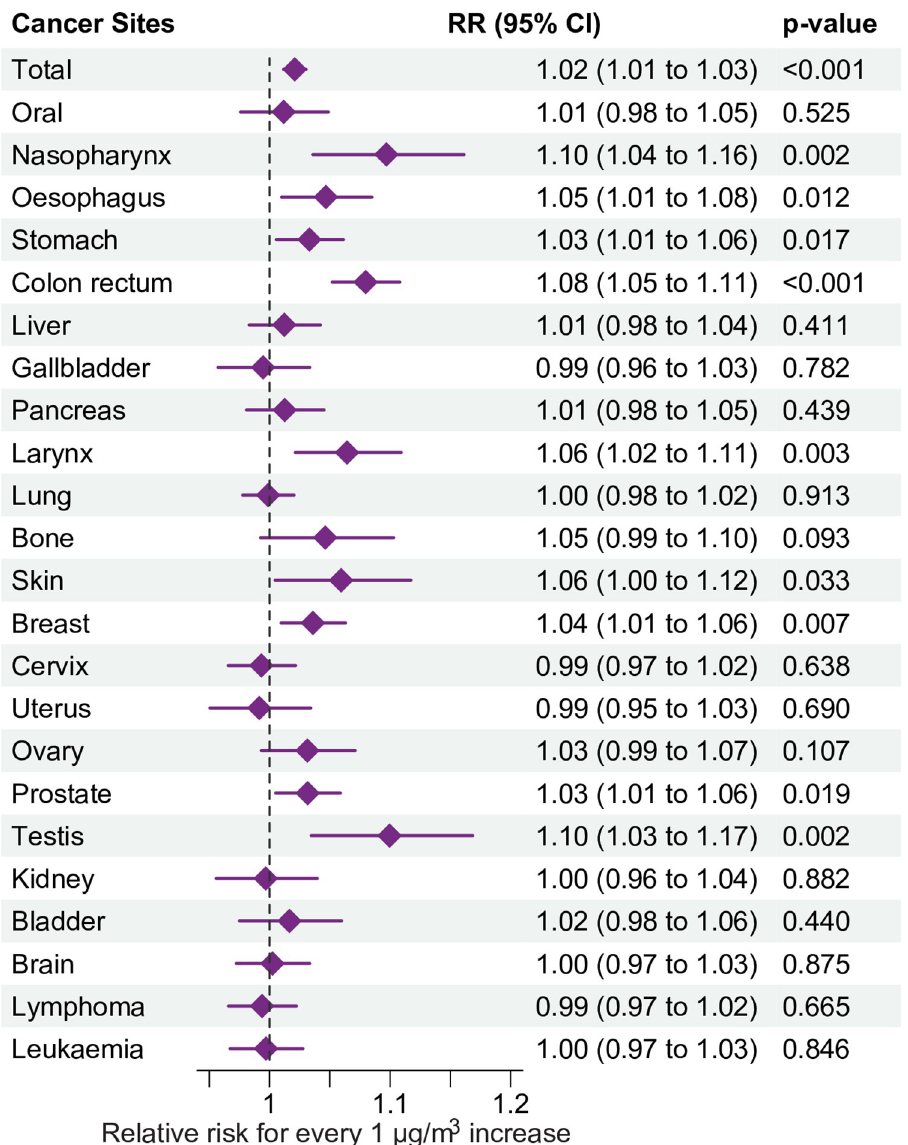
observed between cervical cancer and wildfire-related PM , adverse effects (1.03 [95% CI 2.5 1.01–1.04], p = 0.001) were found for non-wildfire PM (S5 Fig). 2.5 To further examine vulnerable cancer sites and population subgroups, stratified analyses for mortality from potentially affected cancers by age and sex are shown in Fig 4. There was no significant difference for all cancers combined between males (1.02 [95% CI 1.01–1.04], p < 0.001) and females (1.02 [95% CI 1.00–1.03], p = 0.011; p for difference = 0.337) or between